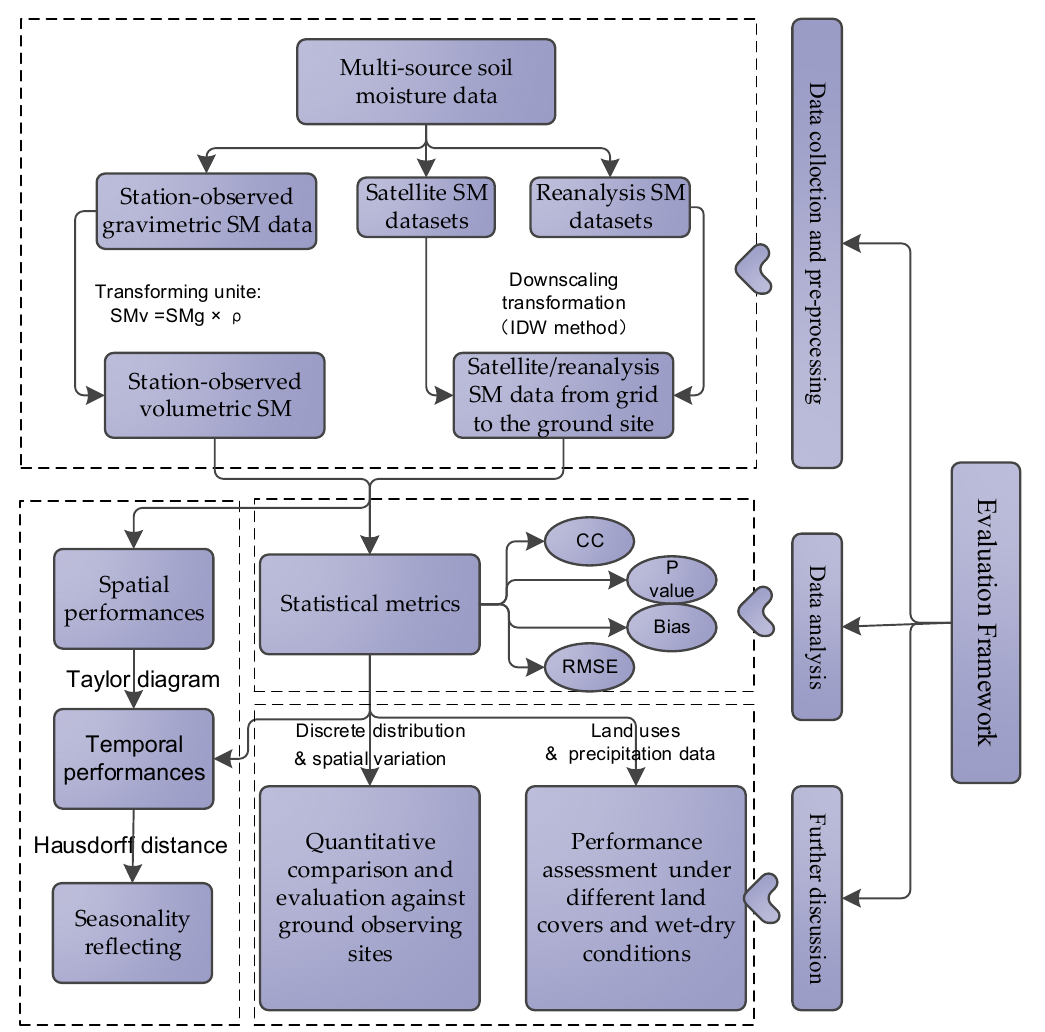
Figure 2. Evaluation framework for satellite/reanalysis soil moisture datasets against the station-observed soil moisture data.